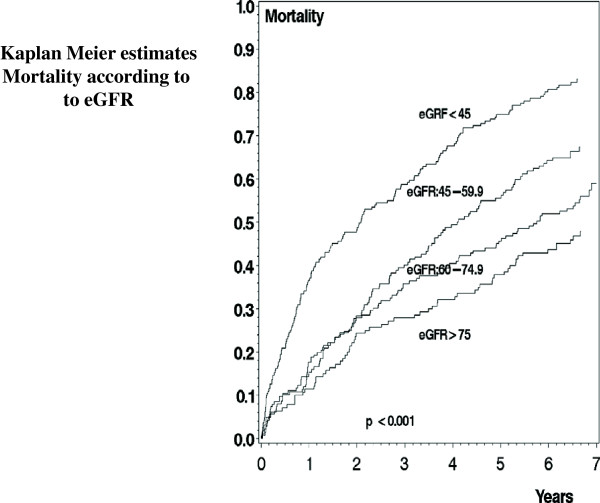
Kaplan Meier estimates according to groups of estimated glomerular filtration rate (Group I: eGFR < 45 ml/min/1.73 m
2
, Group II: eGFR 45.0-59.9 ml/min/1.73 m
2
, Group III: eGFR 60–74.9 ml/min/1.73 m
2 
and Group IV: eGFR >/= 75.0 ml/min/1.73 m
2
).